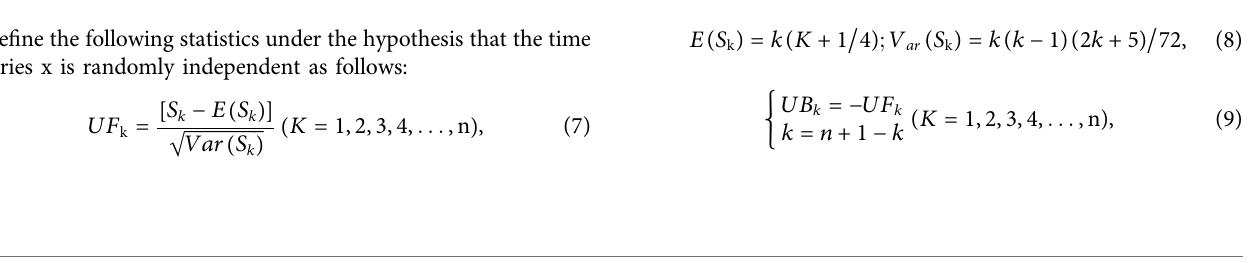
Frontiers in Energy Research |